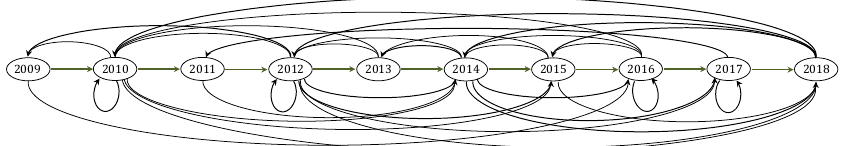
Figure 3. The pattern of transitions between the weather types associated with given annual PPMs as revealed in the 59-year observations.